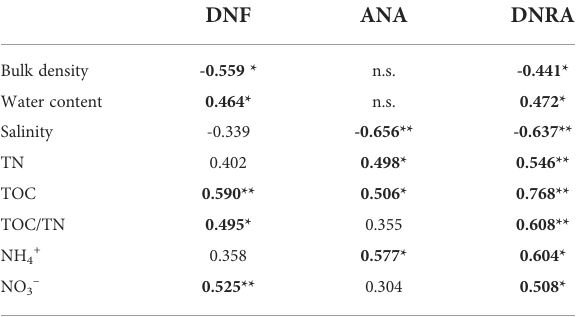
TABLE 3 Person ’ s correlations of sediment NO 3 − reduction rates with physico-chemical